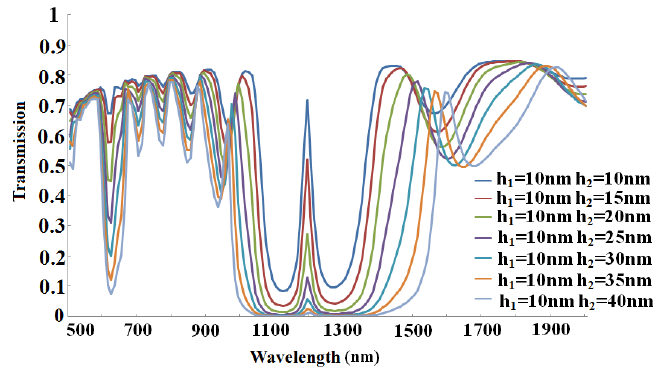
Figure 6. Transmission spectra as a function of wavelength with different heights of later grating with former grating unchanged.